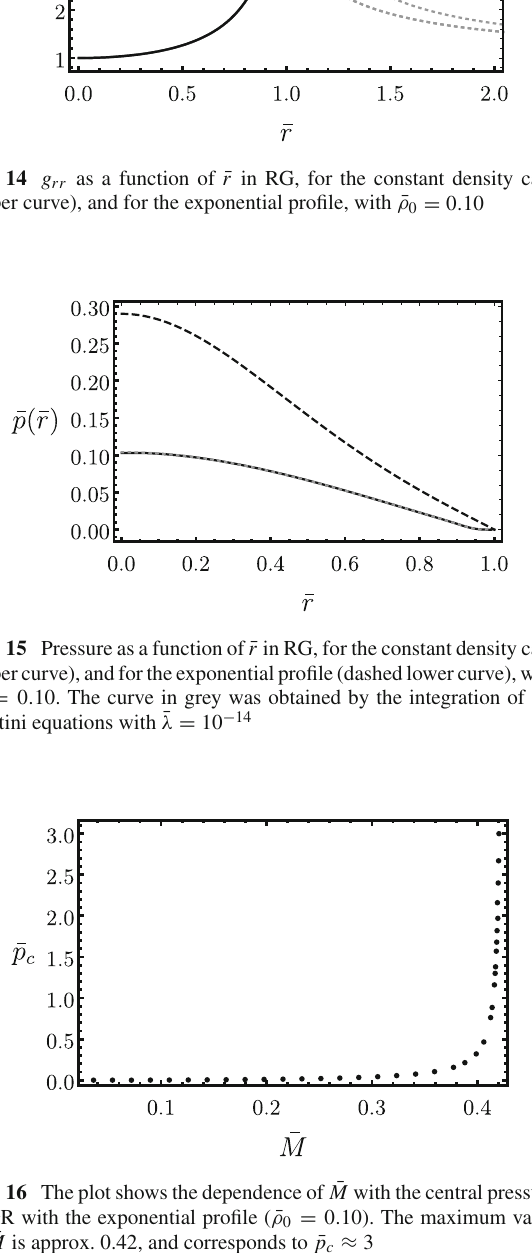
in GR. Due to the requirement that the pressure behaves as in Fig. 1, there is a maximum value both for ¯ p c and by approx. 3 and 0.42,